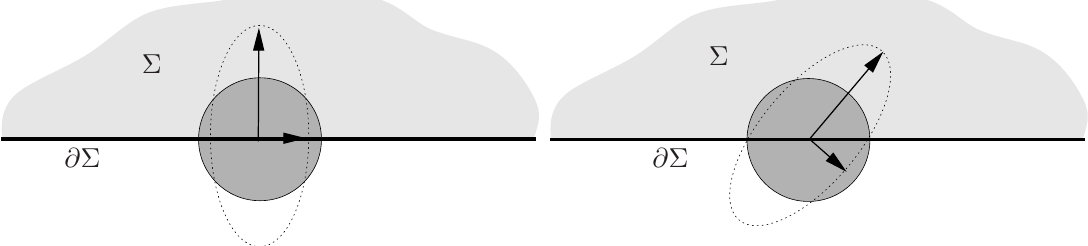
Figure 2. Deformation of a ball of geodesics normal to Σ . On the left panel h ξ = 0: the principal axis of FIG. 2: Deformation of a ball of geodesics normal to Σ. On the left panel h the shear are tangent to ∂ Σ and normal to ∂ Σ . On the right panel h ξ shear are tangent to ∂ Σ and normal to ∂ Σ. On the right panel h 3 When available, the Komar angular momentum is given by